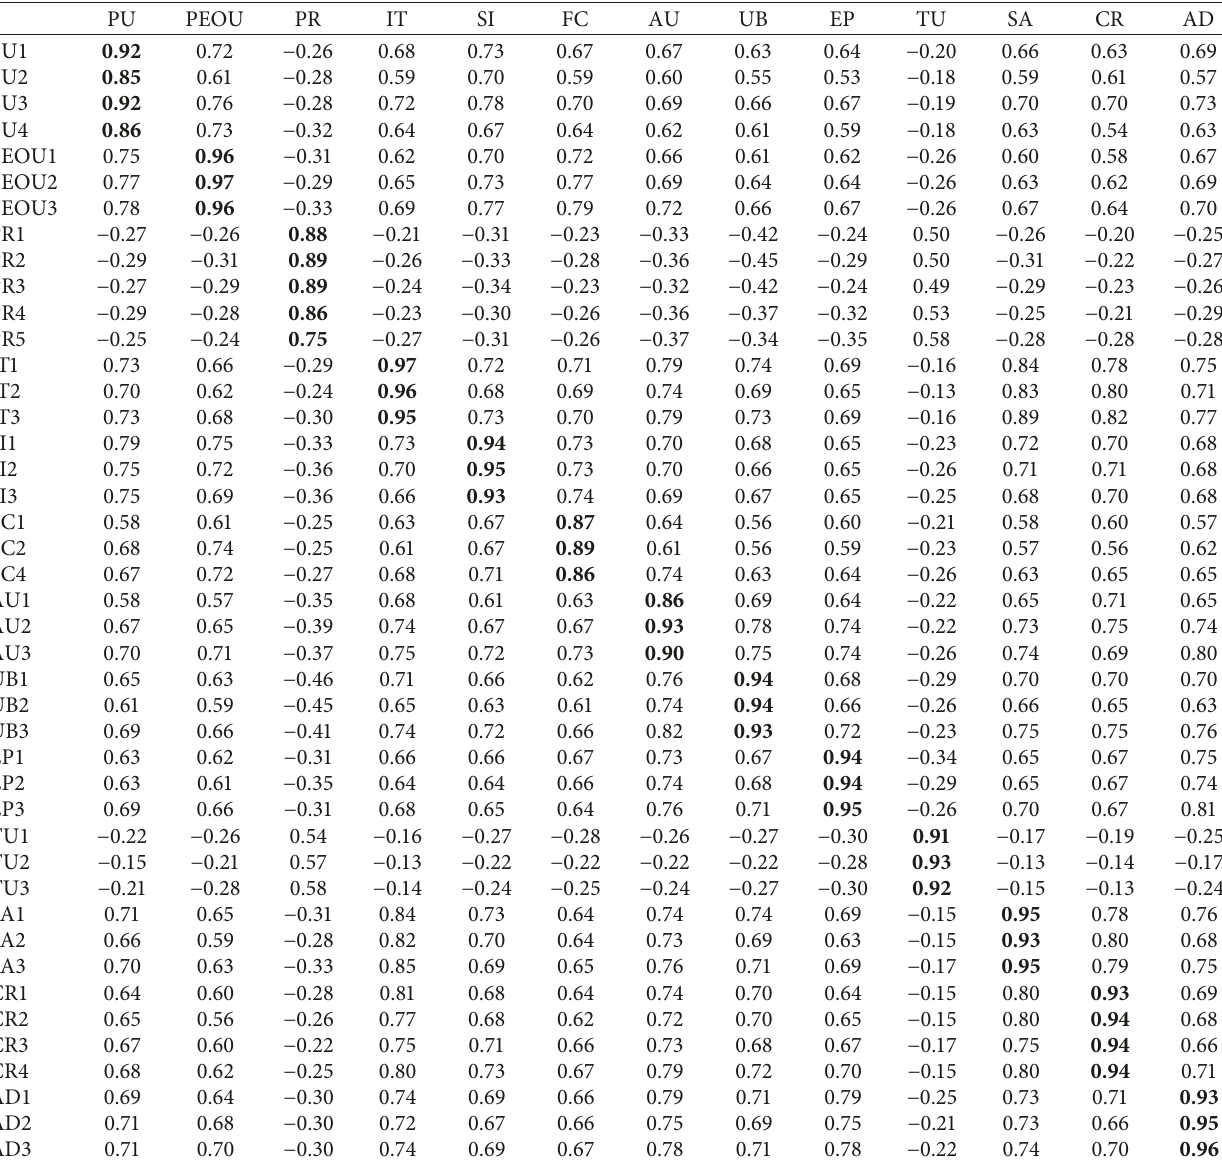
Table 4: Loadings and